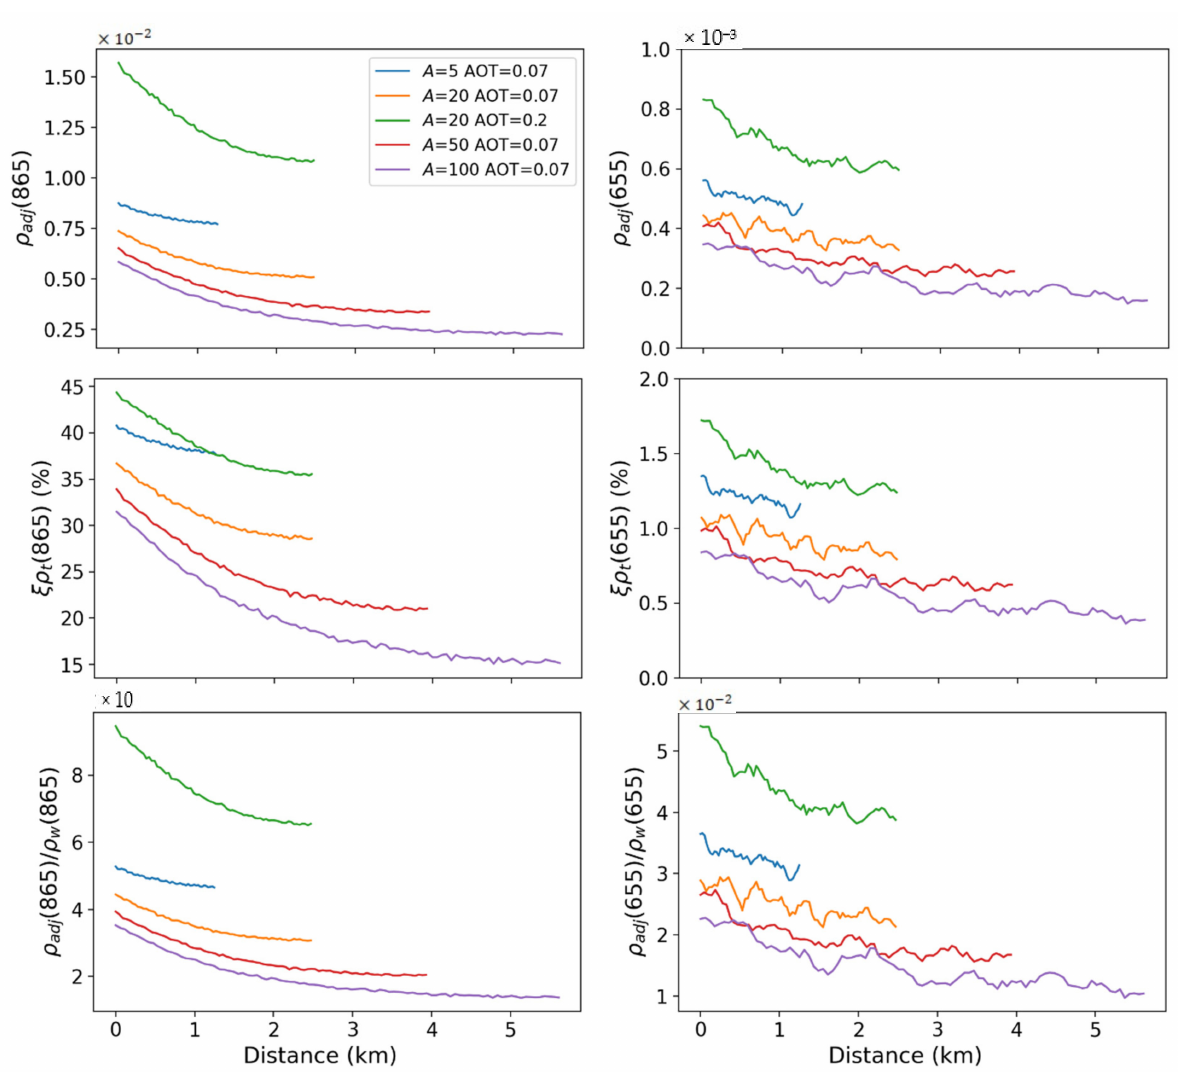
Figure 13. Transect (along a radius) of the adjacency reflectance ρ adj (upper), the percent adjacency reflectance ξρ t (middle), and the ratio of ρ adj / ρ w (bottom) at 865 nm (left) and 655 nm (right) for hypothetical circular lakes with areas of 5 km 2 , 20 km 2 , 50 km 2 , and 100 km 2